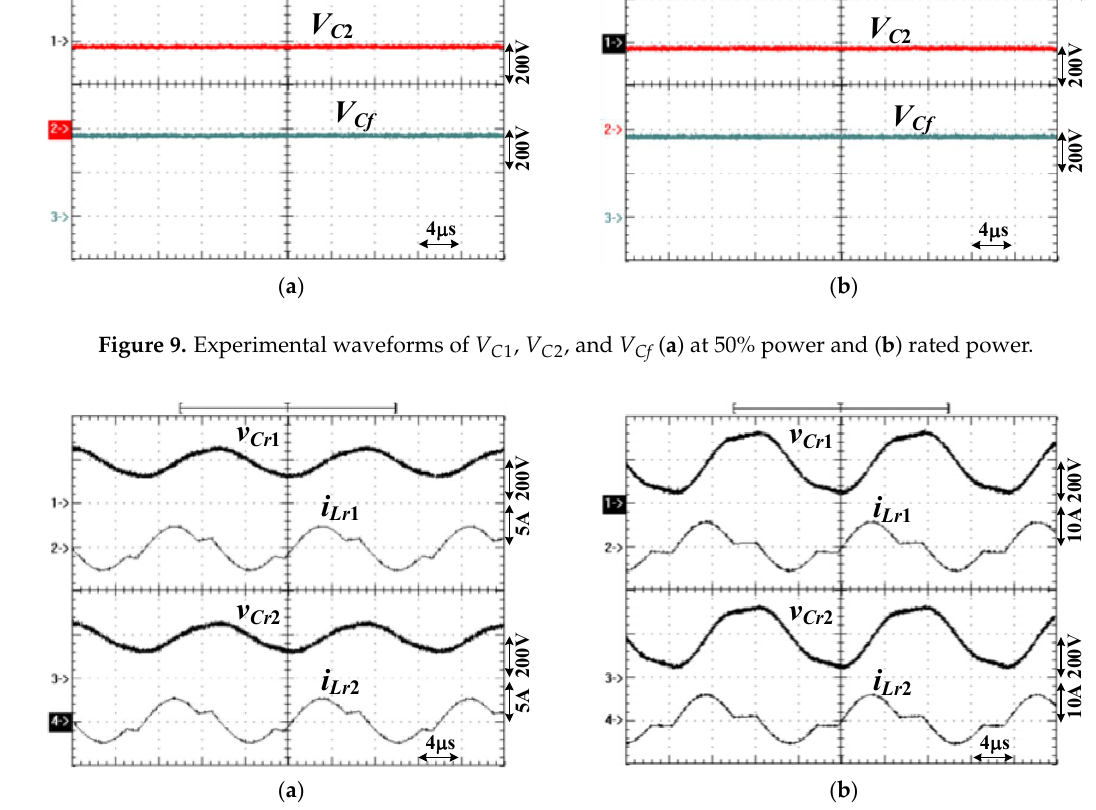
Figure 10. Experimental waveforms of v Cr 1 , v Cr 2 , i Lr 1 , and i Lr 2 ( a ) at 50% power and ( b ) rated power.